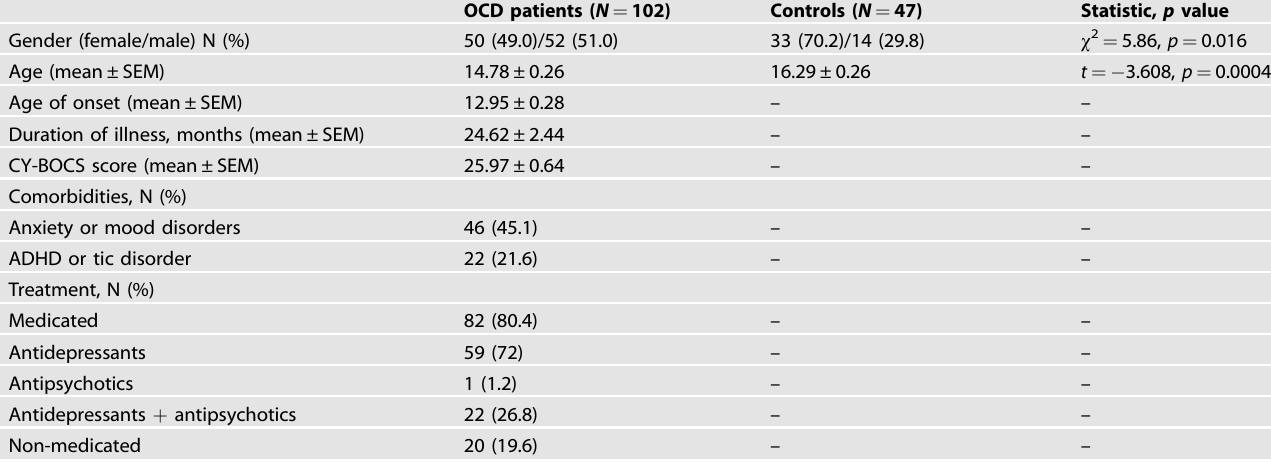
Table 1. Demographic and clinical data of the study